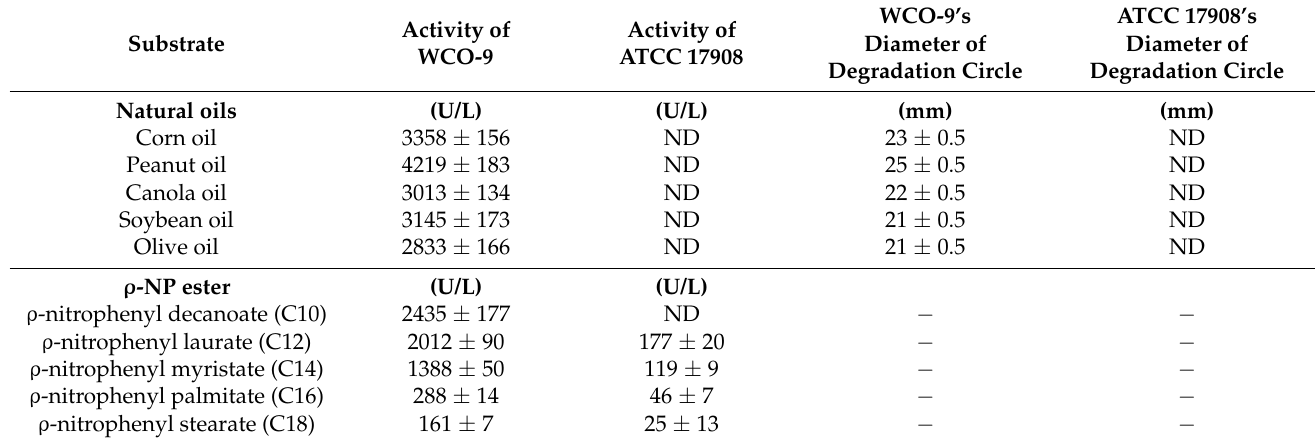
Table 1. Comparison of lipase activity of WCO-9 and ATCC